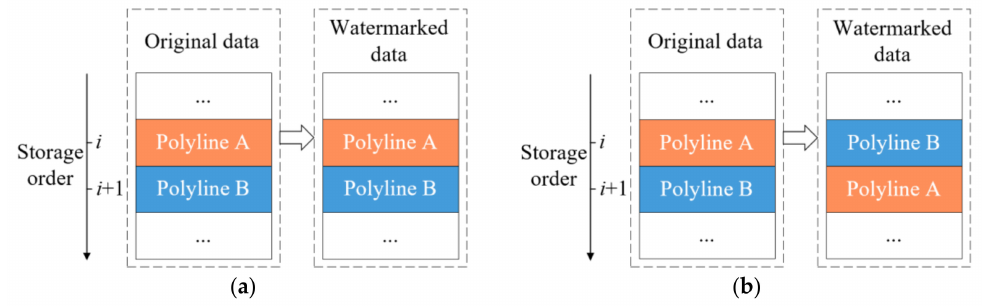
Figure 2. Demonstration of watermark embedding: ( a ) When the watermark bit is 0; ( b ) When the watermark bit is